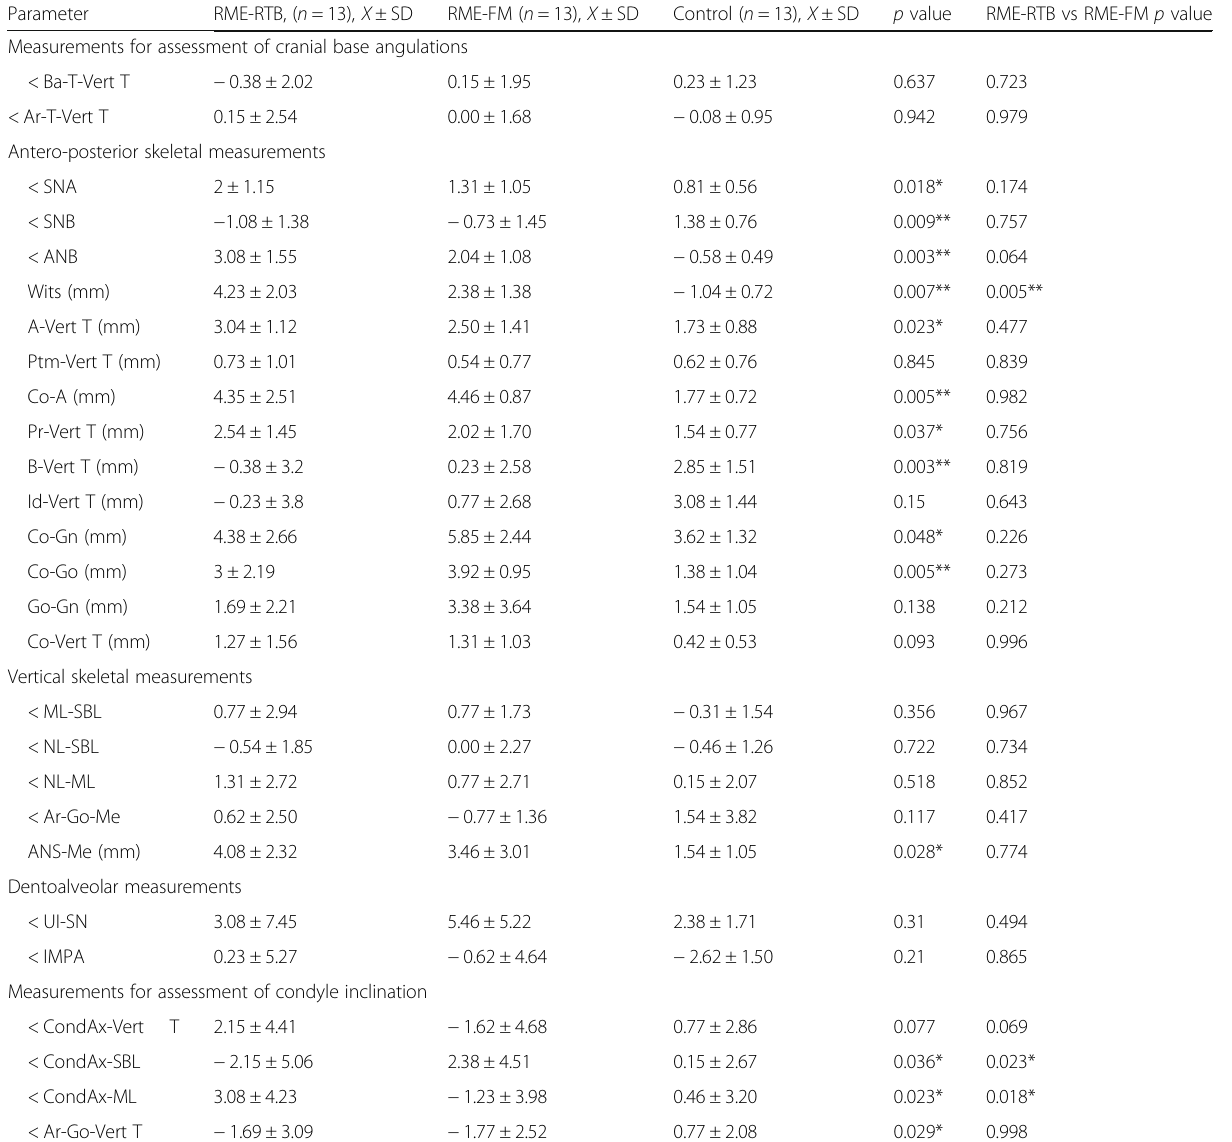
Table 5 Changes occurring in each group during the study period (T2-T1) Parameter RME-RTB, ( n = 13), X ± SD RME-FM ( n = 13), X ± SD Control ( n = 13), X ± SD RME-RTB vs RME-FM p value Measurements for assessment of cranial base